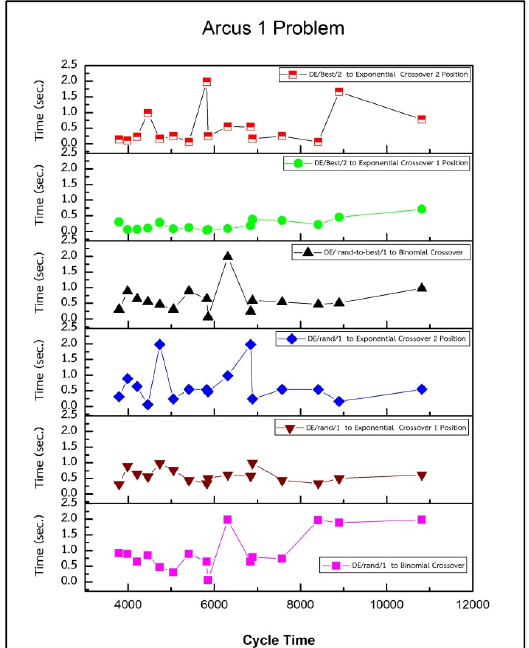
Figure 6. Comparison of Basic and improved DE Algorithm Using Optimal Solution Search Time with Arcus 1 Problem. Arcus 1